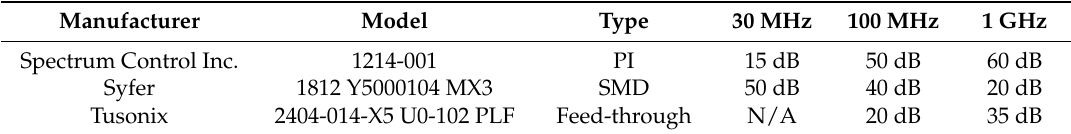
Table 1. Nominal filter attenuations.